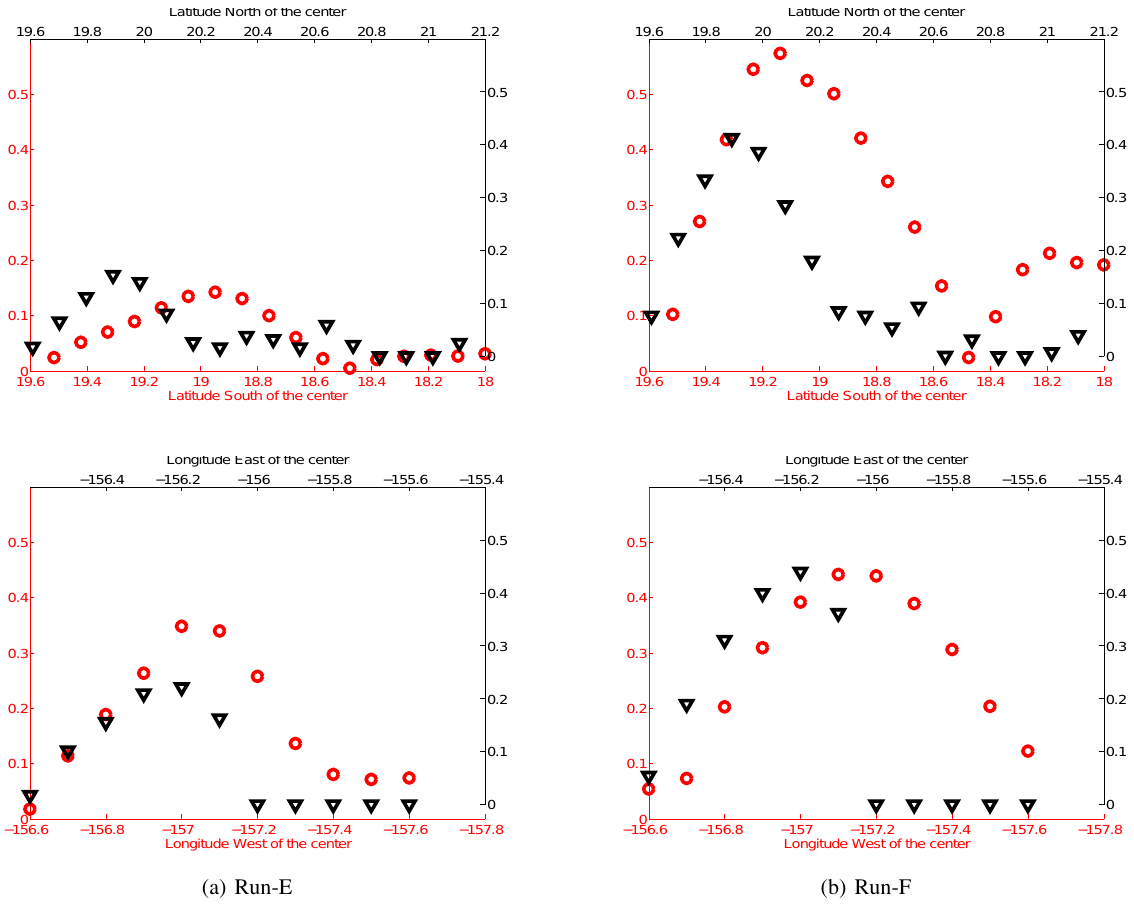
Fig. 13. Distribution of zonal (top) and meridional (bottom) components of the 40-m depth horizontal velocity [ms − 1 ] with respect to the center of the eddy C5-E (Run-E, April 13, left) and of the eddy C1-F (Run-F, March 28, right). structures in Run-F, based on snapshots (3-days